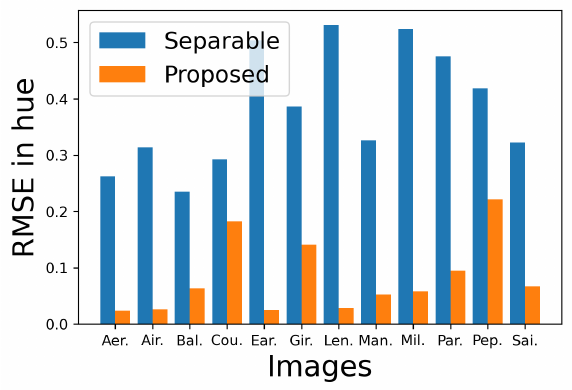
Figure 23. Comparison of the RMSE of hue of the images in Figures 21 and 22 from the original images.